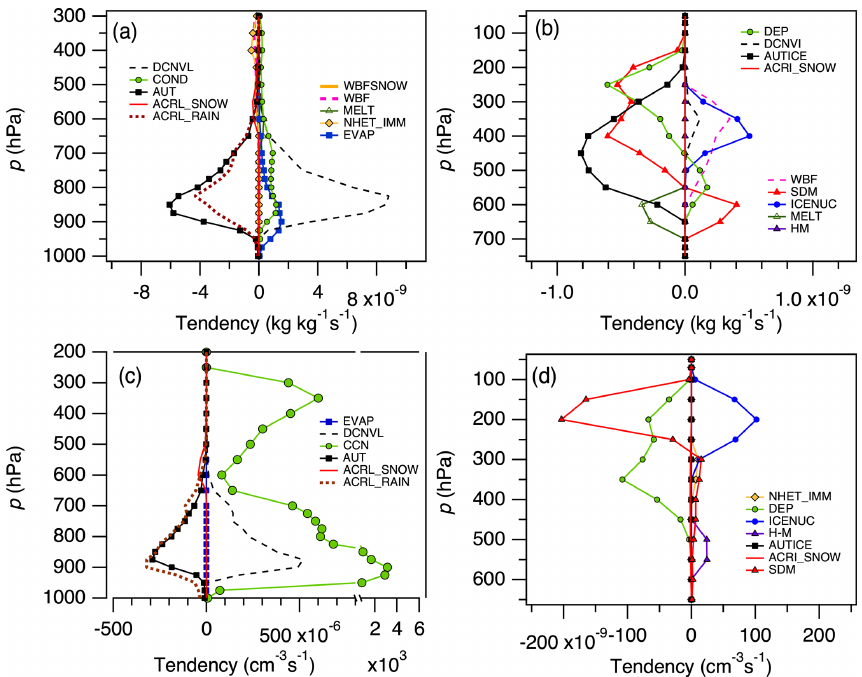
Figure 12. Domain-averaged cloud microphysical tendencies for the 2008 JJA season for (a) liquid mass, (b) ice mass, (c) liquid number, and (d) ice number concentration. Shown are Bergeron–Findeisen processes on ice (WBF) and snow (WBFSNOW), melting (MELT), total ice nucleation and immersion freezing only (ICENUC and NHET_IMM, respectively), droplet evaporation (EVAP), convective detrainment of liquid and ice (DCNVL and DCNVI), condensation (COND), liquid and ice autoconversion (AUT and AUTICE, respectively), accretion of liquid by rain and snow (ACRS and ACRL, respectively), CCN activation (CCN), ice sedimentation (SDM), ice crystal growth and accretion by snow (DEP and ACRI_SNOW, respectively), and ice splintering